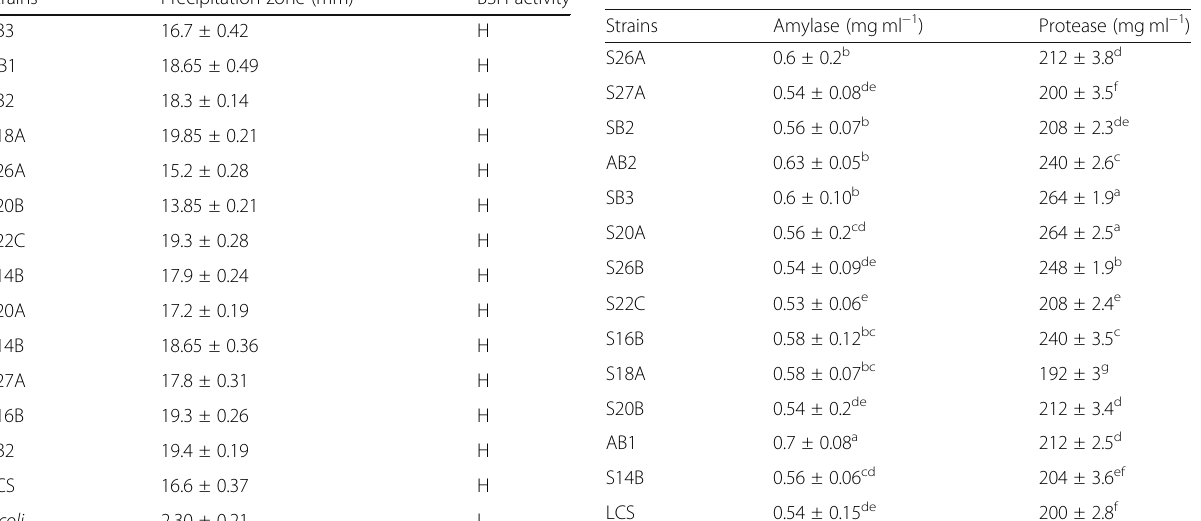
Table 2 Bile salt hydrolase activity